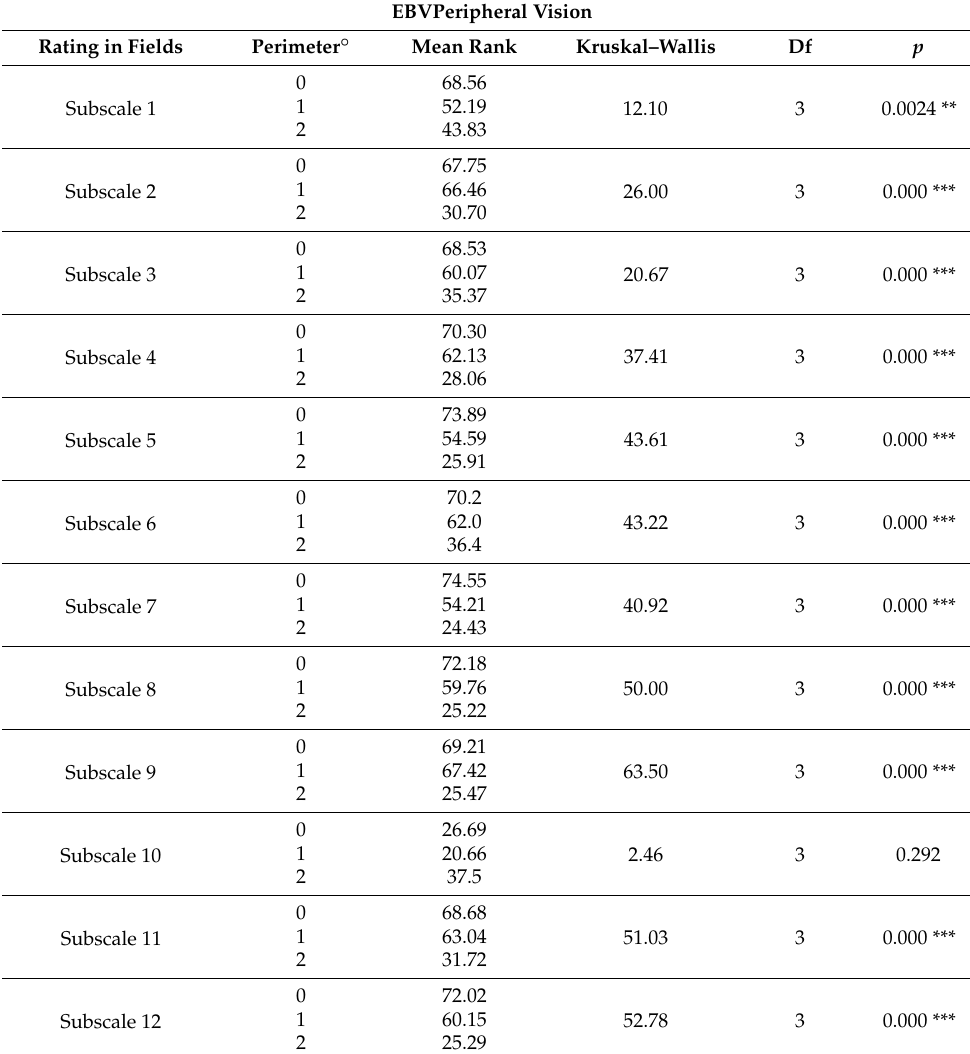
Table 7. Statistical evaluation of the NEI VFQ-25 by Kruskal–Wallis test of the EBV and EWV: peripheral